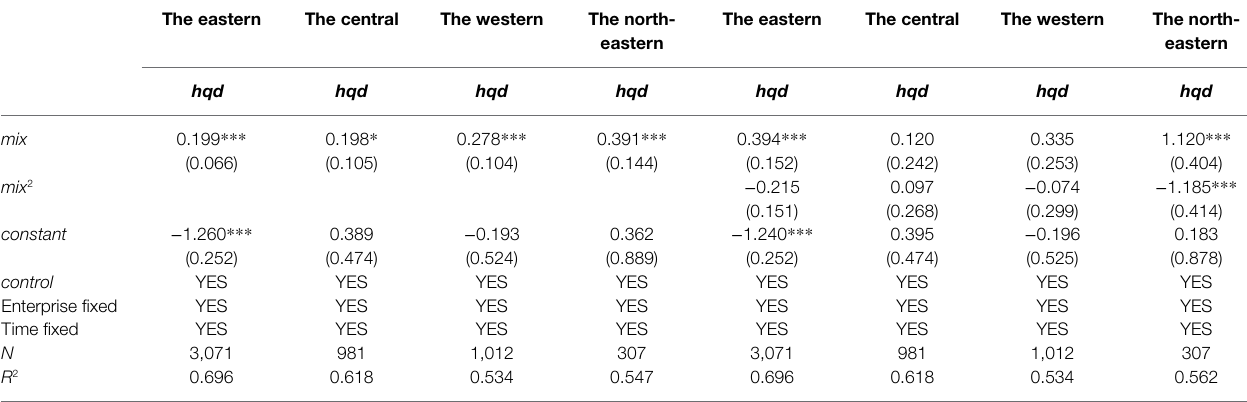
TABLE 8 | The analysis of regional heterogeneity. The eastern